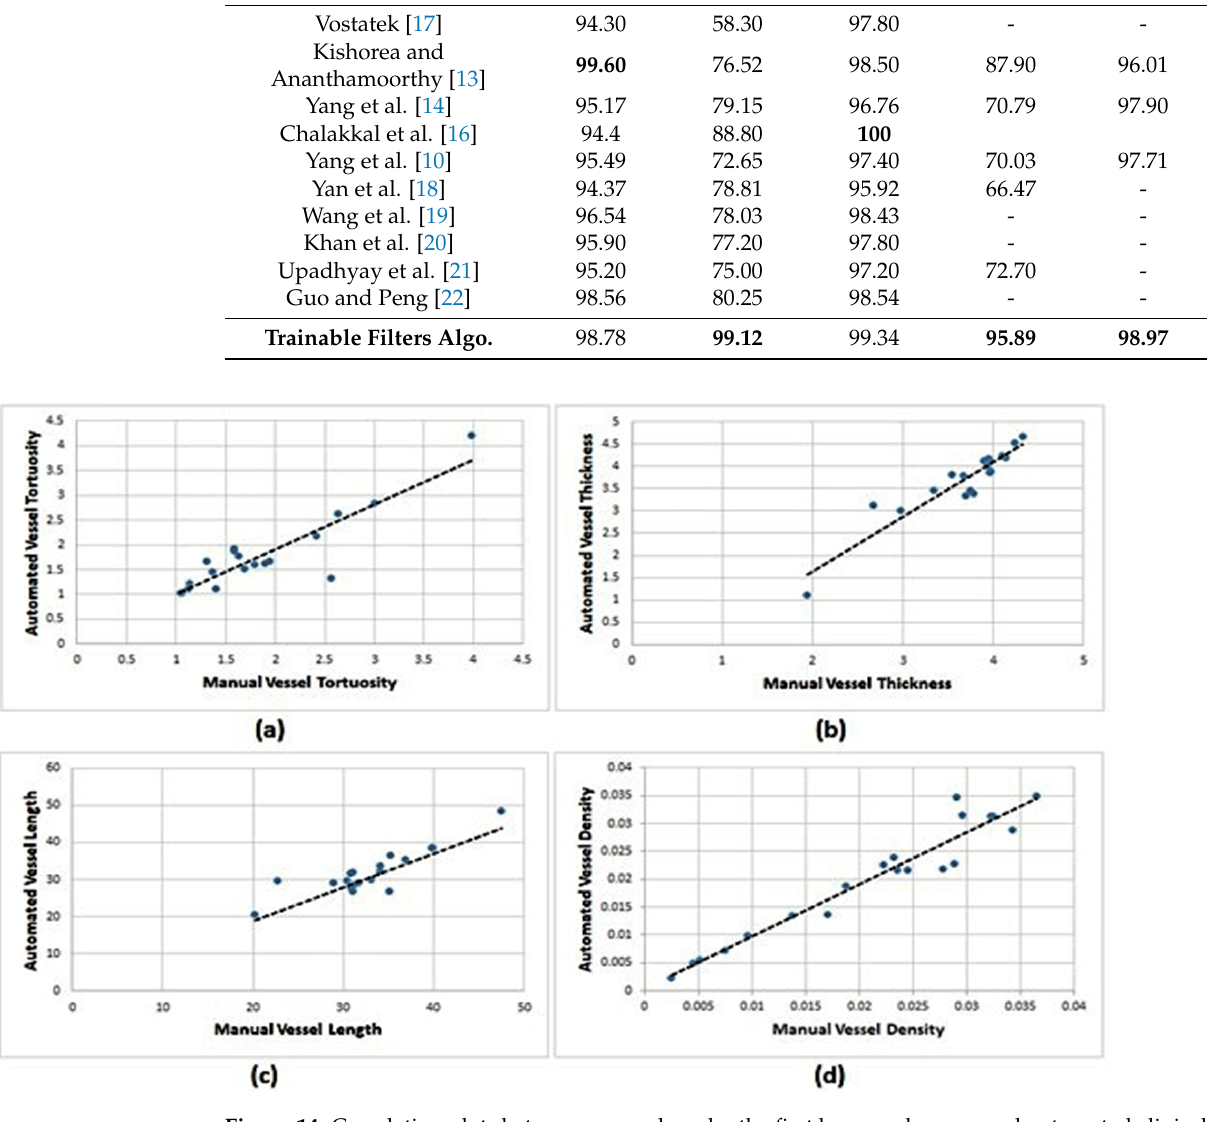
Figure 14. Correlation plots between manual use by the first human observer and automated clinical estimations from the DRIVE dataset using the proposed trainable filters algorithm: ( a ) tortuosity; ( b ) thickness; ( c ) length; and ( d ) density. Further evaluation was performed on the HRF Dataset, which contains 40 GT images constructed to efficiently assess the performance of the proposed blood vessel segmentation algorithms. Table 7 shows the overall AV., STD, Max, and Min of each clinical feature. The manual and automated images were computed along with the Diff and Diff % between them. The average Diff % between the manual and automated estimations calculated using the proposed trainable filter algorithm were 2.560%, 12.59%, 2.484%, and 5.529% for tortuosity, thickness, length, and density, respectively. Correlation plots between the manual and automated clinical estimations from the HRF dataset using the proposed trainable filtering algorithm are presented in Figure